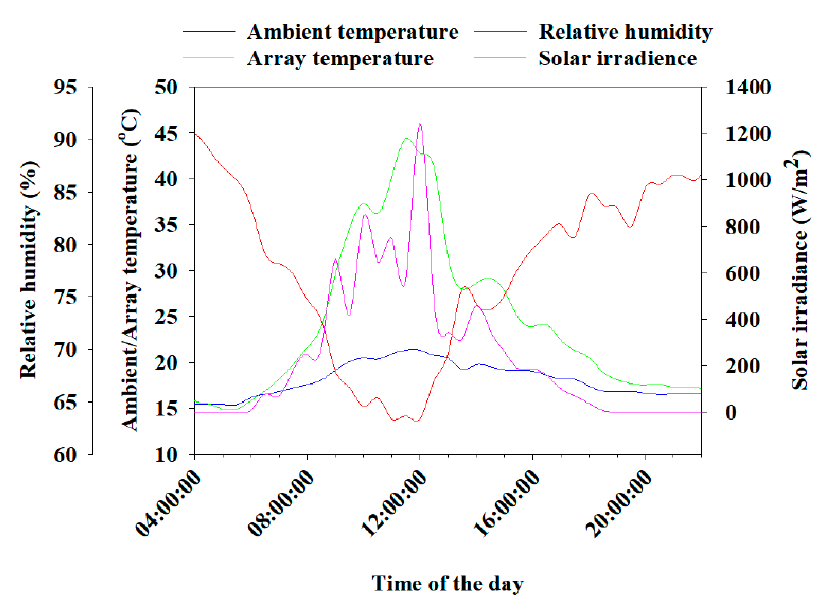
Figure 13. Measured data from CR1000 data logger during a rainy day in February 2018 at the University of Fort Hare, South Africa.